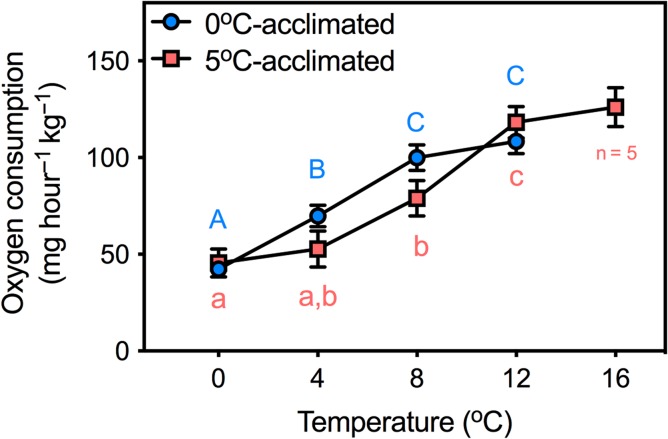
The effects of 0 and 5°C acclimation (6–9.5 weeks) on oxygen consumption during an acute thermal challenge. Significant differences were evaluated with two-way ANOVA. Dissimilar letters indicate significant differences within an acclimation group. There were no significant differences between acclimation groups at any temperature. N = 7 for 0°C-acclimated fish and N = 6 for 5°C-acclimated fish (except at 16°C where N = 5). Data are mean ± SEM